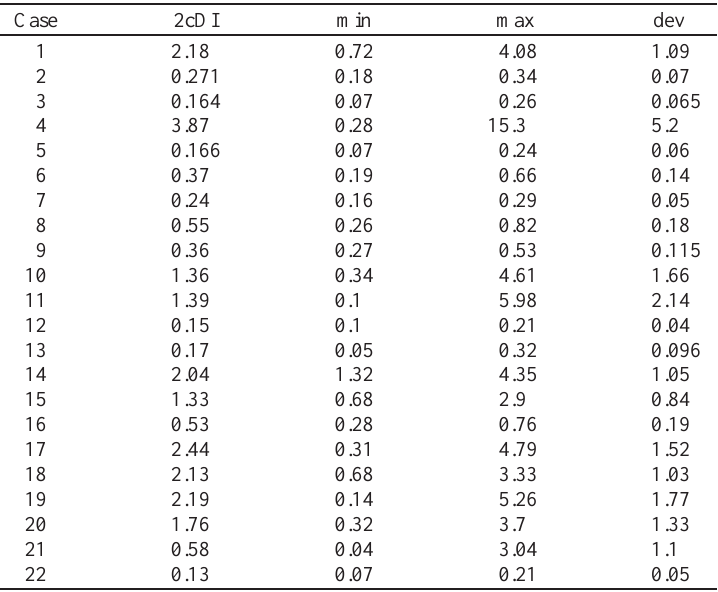
Table 5 Distribution of the 2c-deviation-indices (2cDI) in the investigated